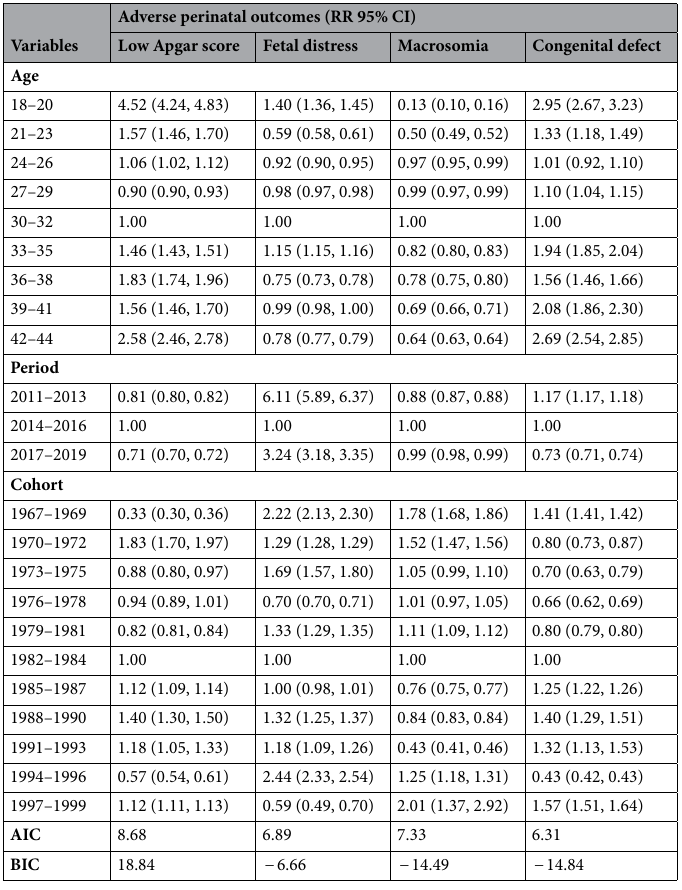
Table 5. Age-Period-Cohort effects on low Apgar score, fetal distress, macrosomia, and congenital defect. RR risk ratio, CI confidence interval, AIC Akaike information criterion, BIC Bayesian information